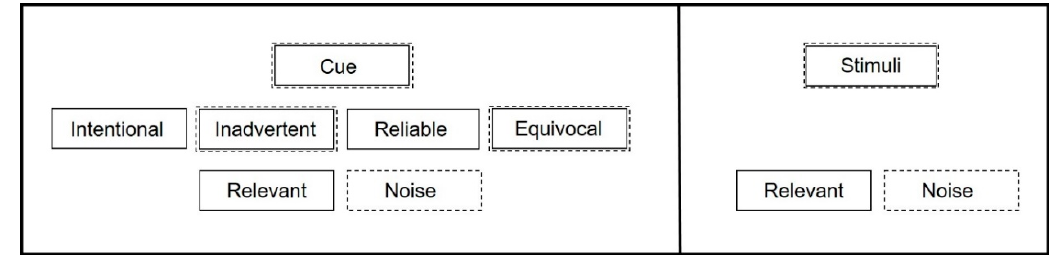
Figure 1. Different subsets of cues and their potential to provide relevance or become noise to animals. Solid boxes indicate types of cues with potential to provide relevance for animals. Dashed boxes indicate types of cues with potential to become noise. Ambient stimuli may also be relevant or noise to animals, but are not generated by human caretakers.